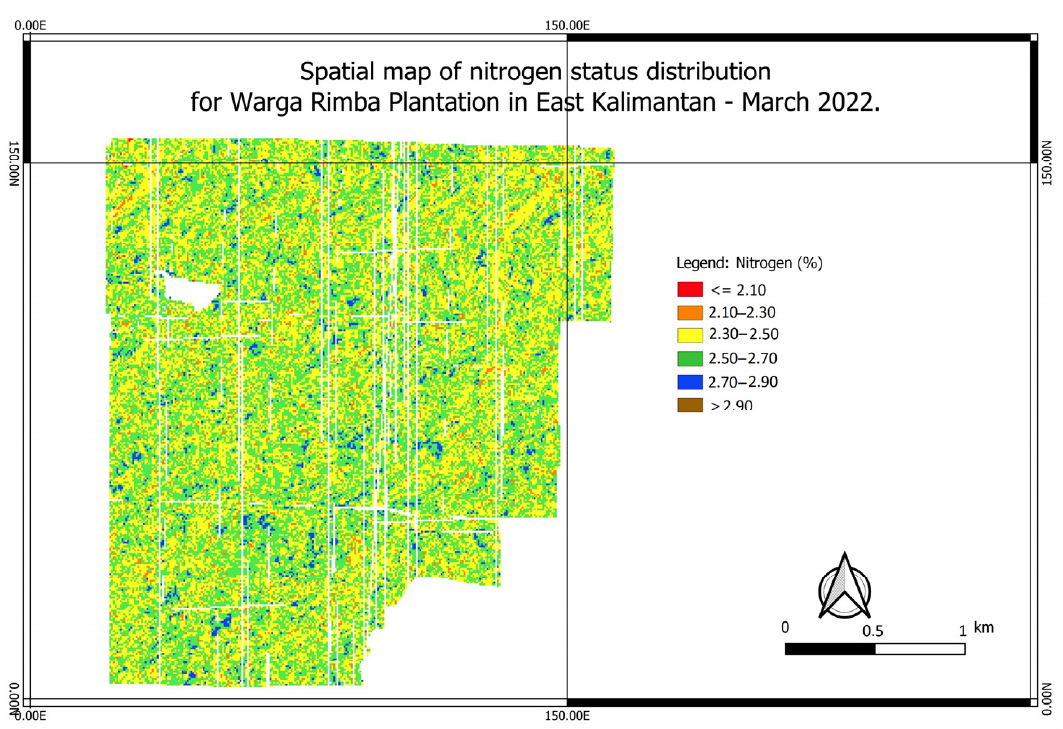
Figure 9. Spatial map of nitrogen status distribution for Warga Rimba plantation in East Kalimantan March 2022.